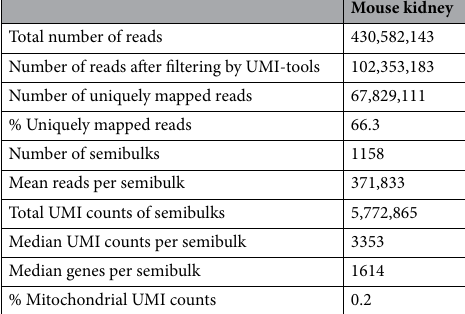
Table 1. Summary of mouse kidney sbRNA-seq.